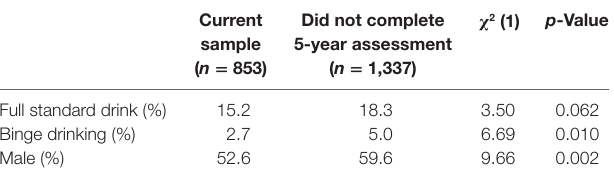
TaBle 3 | Comparison of participants in the current sample compared with those who did not complete the 5-year follow-up